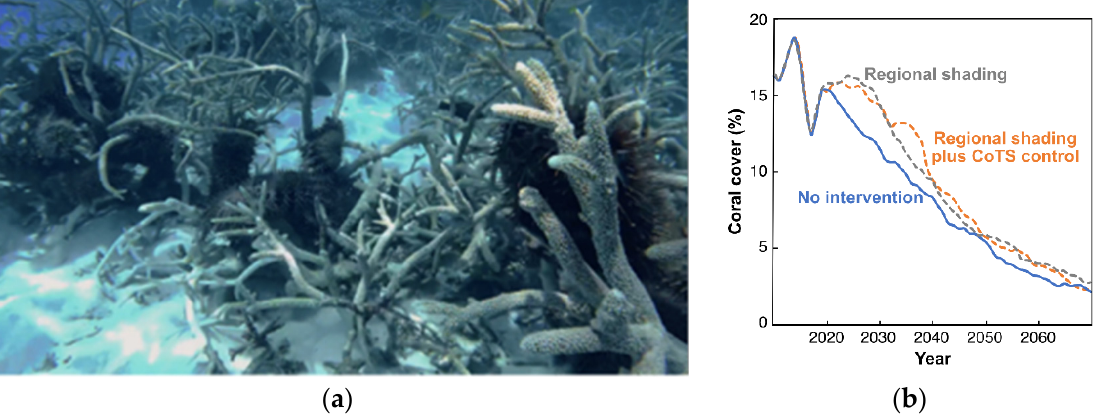
Figure 9. ( a ) COTS outbreak consuming live staghorn coral. ( b ) Management scenario effects on coral cover on the GBR showing coral cover with no interventions, with regional shading of reefs, and with regional shading combined with CoTS control (adapted from [67]).